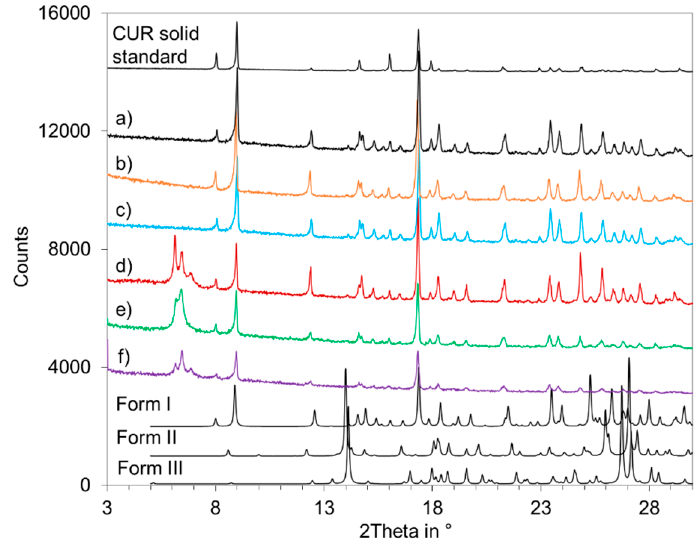
Figure 4. X-ray powder diffraction (XRPD) patterns of CUR crystalline phases ( a ) obtained from isothermal equilibration of CUR suspensions, and ( b – f ) recrystallized by cooling of saturated CUR solutions in acetone ( b ), acetonitrile ( c ), methanol ( d ), ethanol ( e ), 2-propanol ( f ). The topmost diffractogram refers to the CUR solid standard. The three lowermost diffractograms specify the reference crystal structures of CUR polymorphs I-III simulated from CSD single crystal data [42].